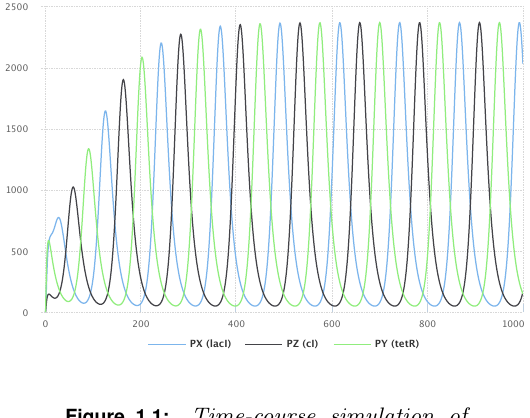
Figure 1.1: Time-course simulation of the repressilator depicting repressor pro- teins lacI, tetR and cI. Simulation with SED-ML web tools [2].